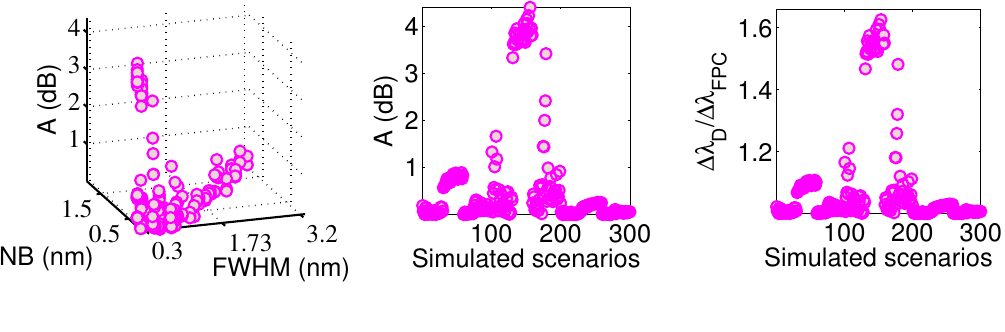
as a function of the simulated ∆ λ FPC